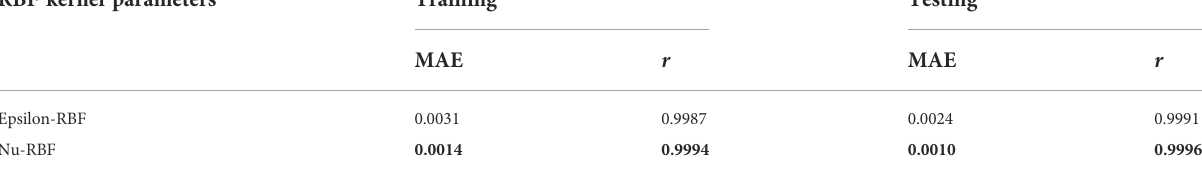
The best RBF kernel function is highlighted in bold.